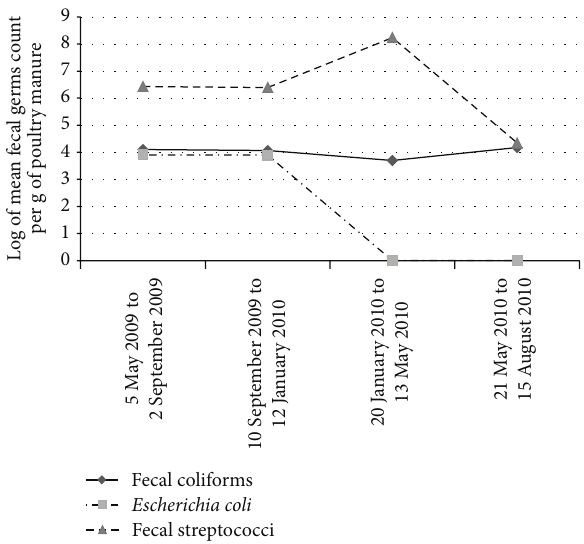
Figure 1: Changes in populations of the three fecal microorganisms in poultry manure over the four growing periods (coastal area of Benin,